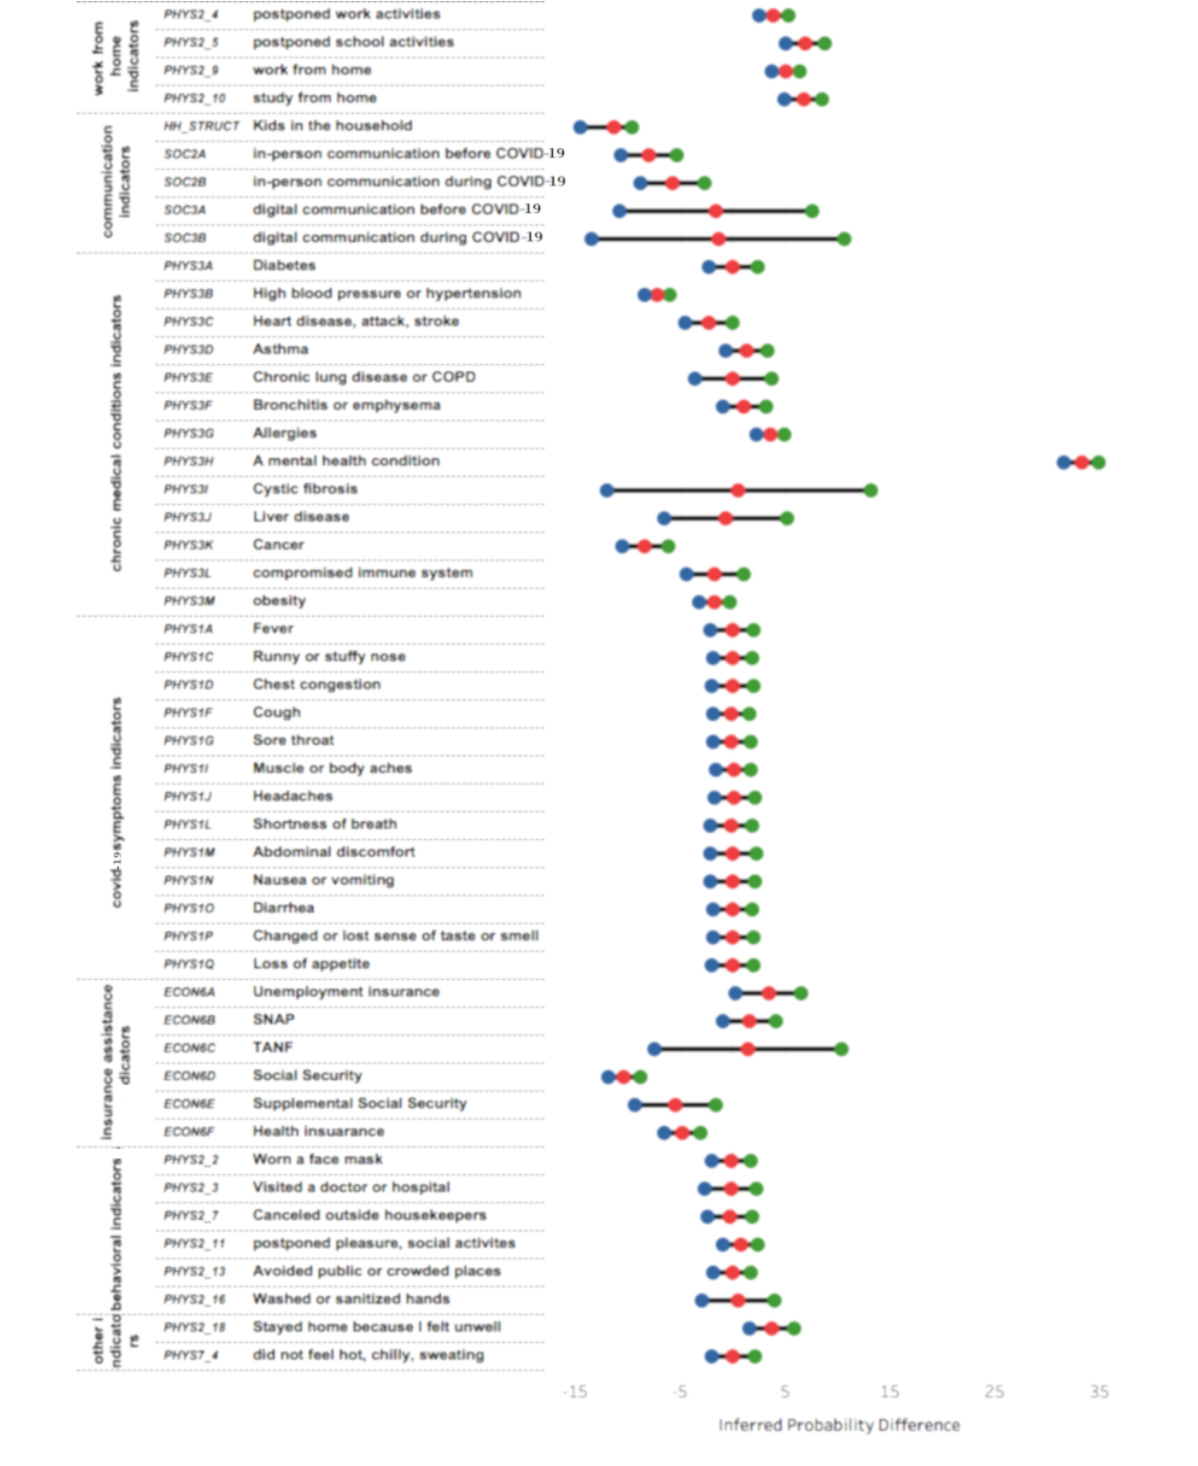
Figure 5. Inferences from the Bayesian network. The difference in inferred probability was calculated after conditioning the independent variables. A positive association implies a mental stress–inducing factor, whereas a negative association implies a mental stress reduction factor. The red circle shows the mean value, with green and blue showing confidence intervals. COPD: chronic obstructive pulmonary disease; SNAP: Supplemental Nutrition Assistance Program; TANF: Temporary Assistance for Needy